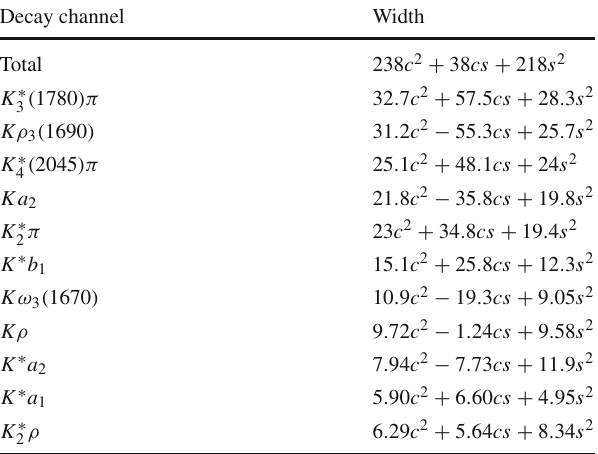
Table 16 The strong decay widths of K 4 ( 2550 ) assigned toa 2 G (cid:5) state, where s and c represent sine and cosine functions. The unit of the width is MeV Decay channel Width Total 238 c 2 + 38 cs + 218 s 2